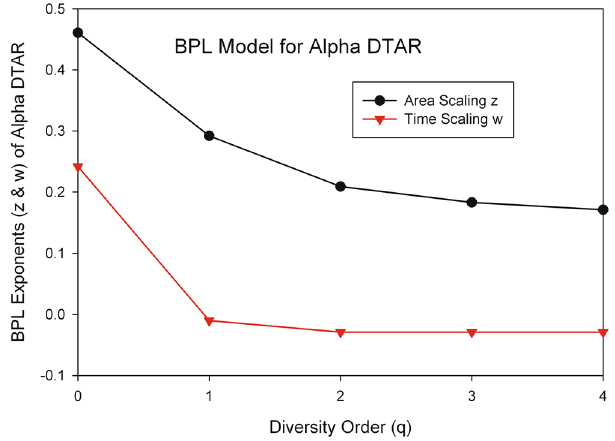
Figure 7. The parameters z & w of the BPL (bivariate power law) for the